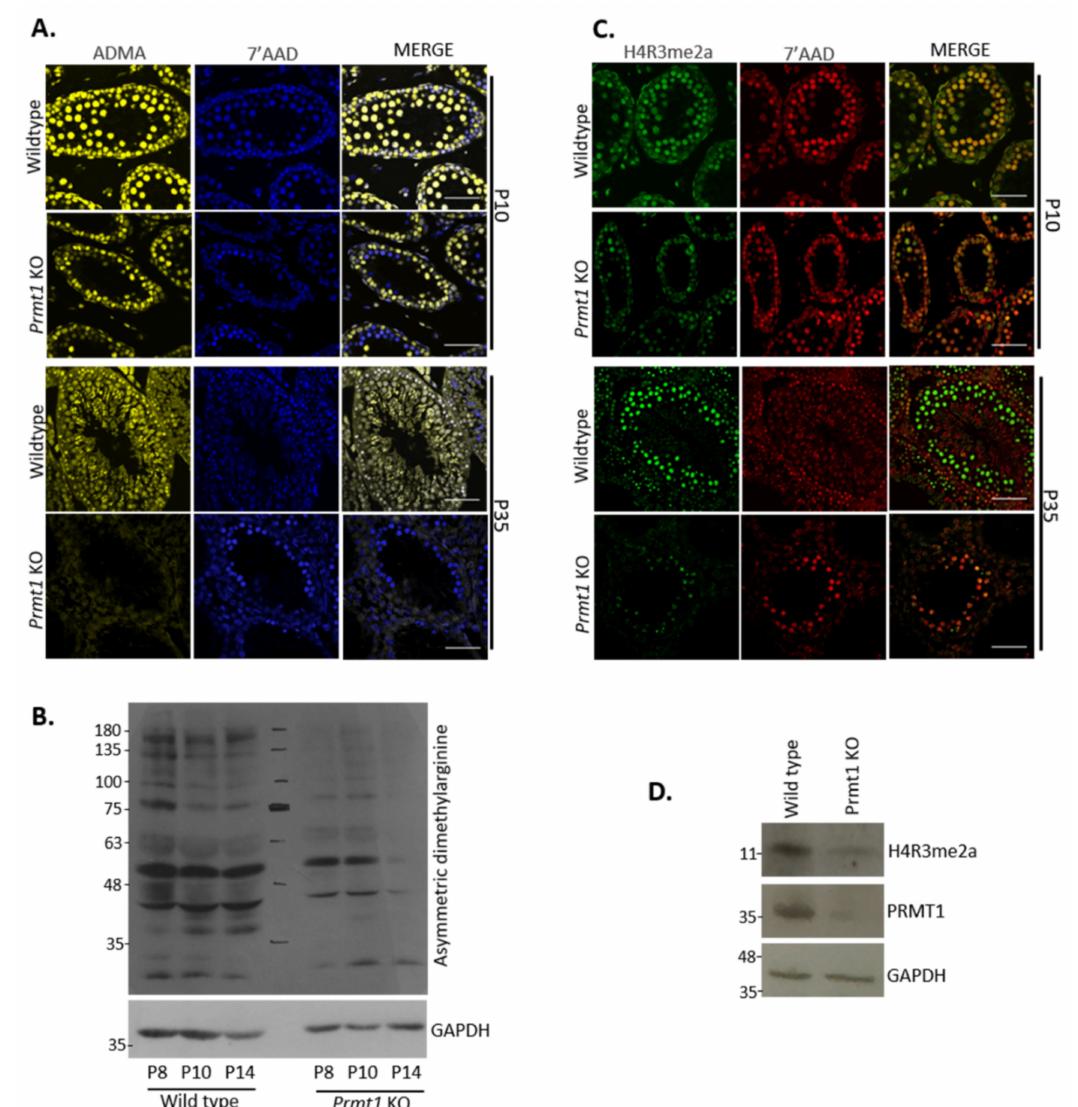
Figure 2. PRMT1 deficiency leads to the reduction of global asymmetric dimethylation as well as asymmetrical dimethylation on arginine-3 of histone H4 (H4R3me2a) in male germ cells. ( A ) Detection of asymmetric dimethylarginine (ADMA) (yellow) mark in wildtype and Prmt1 KO testes on P10 and P35 by immunofluorescence. DNA was stained with 7 (cid:48) -AAD (blue). Scale bar, 50 µ m. ( B ) Western blot analysis to check total ADMA in total protein from wildtype and Prmt1 KO testes on P8, P10, and P14. GAPDH was used as an endogenous control. ( C ) Detection of H4R3me2a (green) expression in wildtype and Prmt1 KO testes on P10 and P35 by immunofluorescence. DNA was stained with 7 (cid:48) -AAD (red). Scale bar, 50 µ m. ( D ) Western blotting analysis to check H4R3me2a of total protein from wildtype and Prmt1 KO testes at P20. GAPDH was used as an endogenous